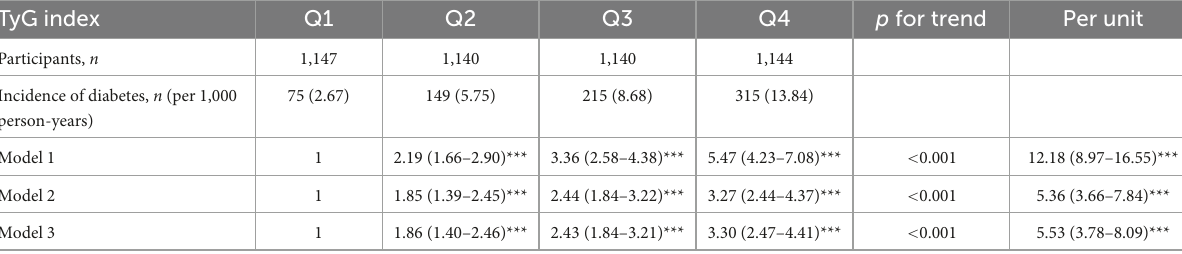
TABLE 2 Incidence of diabetes in relation to quartiles of TyG index in MDC-CC ( n = 4,571, incident diabetes, n = 754). TyG index